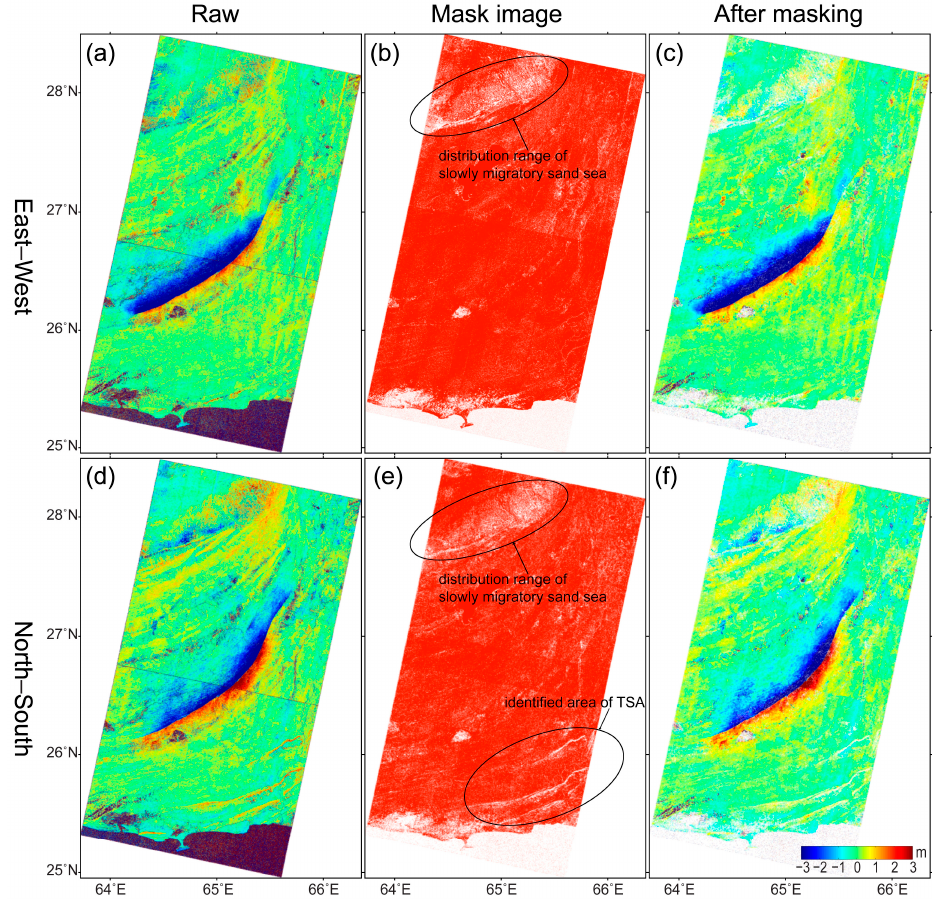
Figure 10. Horizontal coseismic deformation of the 2013 Mw 7.7 Balochistan, Pakistan earthquake obtained by our small radiometric baseline method, before and after masking out TSA and other non-targeted offsets: ( a ) E/W displacement field before masking; ( b ) E/W mask image, in which the white denotes the region that need to be masked; ( c ) E/W displacement field after masking; ( d ) N/S displacement field before masking; ( e ) N/S mask image; and ( f ) N/S displacement field after masking.